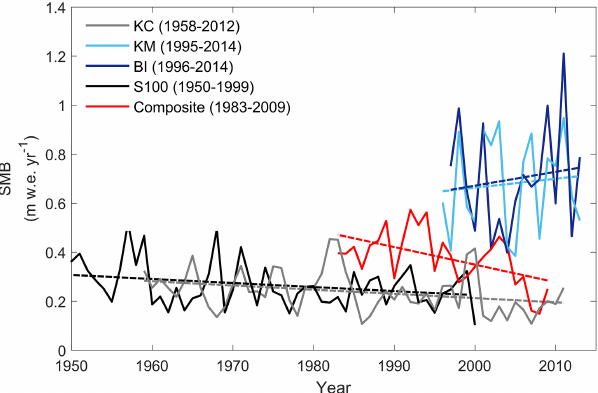
Figure 5. Annual SMB for KC, KM, and BI cores compared to S100 (Kaczmarska et al., 2004) and the composite FIS core record (Schlosser et al., 2014). The dashed lines are the linear regression for the entire period covered by the respective